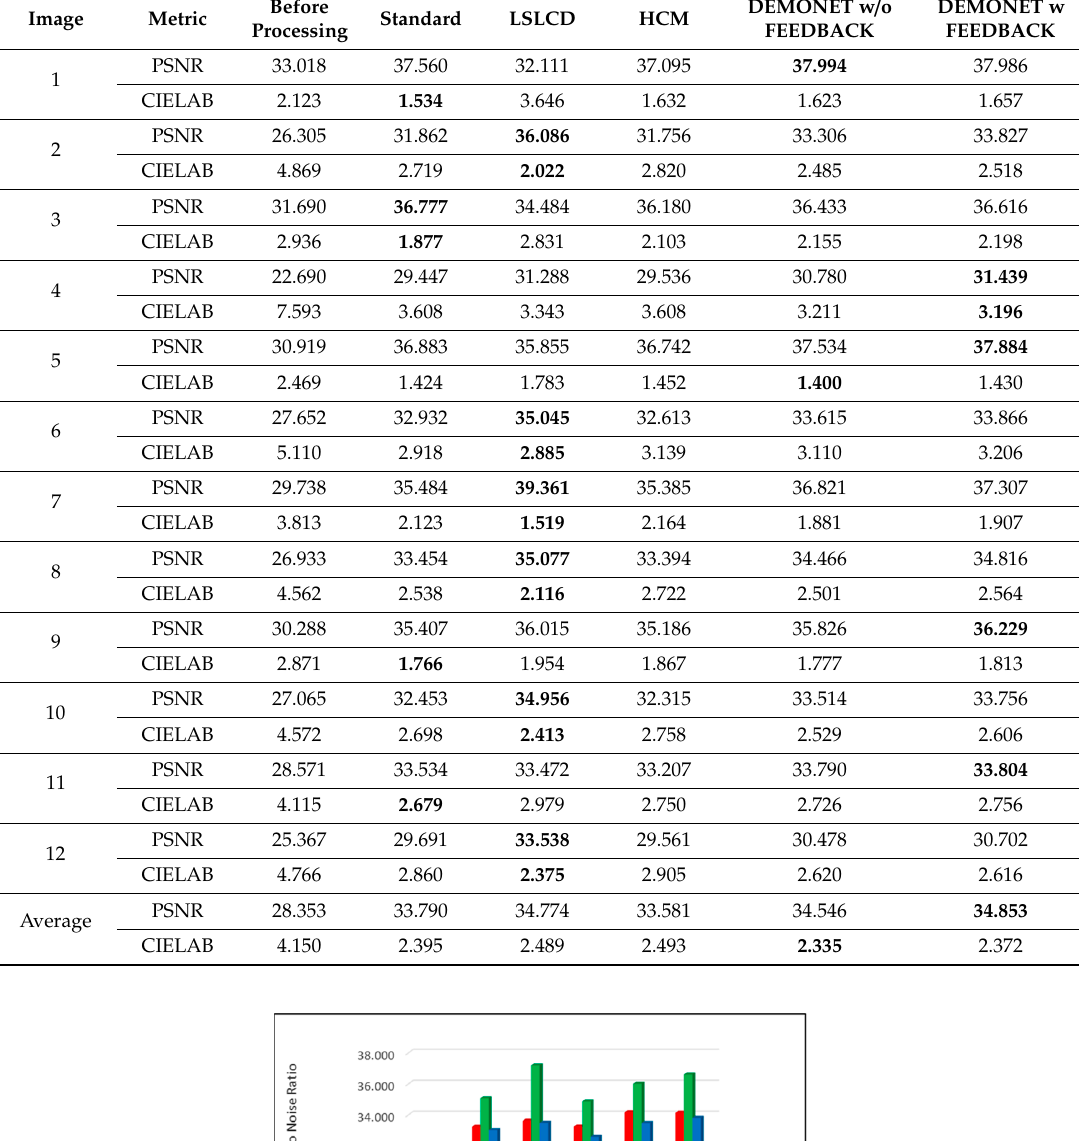
Table 3. PSNR and CIELAB metrics of various algorithms: Kodak data. Bold numbers indicate the best performing method in each row.